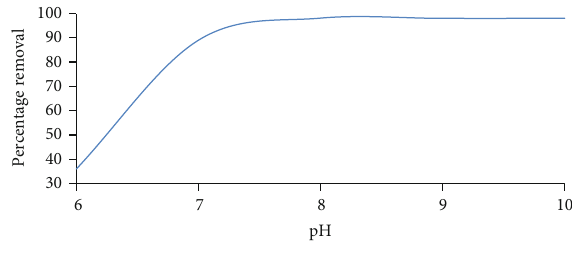
Figure 9: E ff ect of pH on % removal of Mn(II).